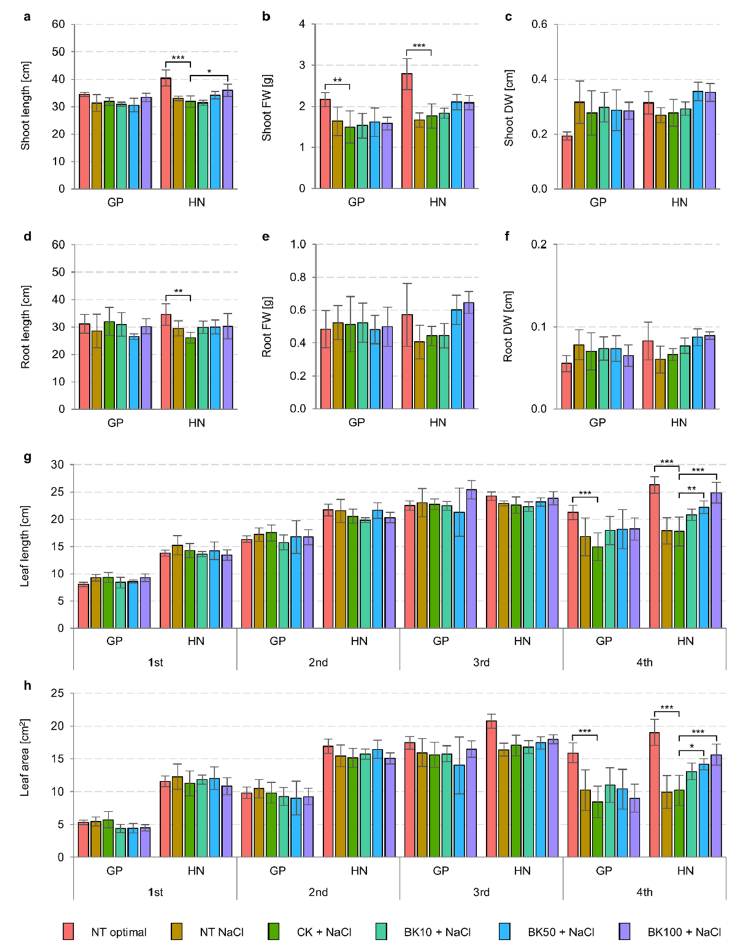
Figure 1. Treatment with bikinin resulted in phenotypic changes in barley grown under normal and salt stress conditions. Shoot length ( a ), fresh ( b ), and dry ( c ) biomass and root length ( d ), fresh ( e ), and dry ( f ) weight, and leaves’ length ( g ) and area ( h ) after bikinin treatment with 10 µM, 50 µM, and 100 µM (BK10, BK50, and BK100, respectively), compared to controls with 0.11% DMSO (CK) used as a background for solvent solutions for each bikinin concentration. Non-treated plants were used as a control for the 0.11% DMSO treatment. The values in ( a – h ) represent the mean and standard error for six biological replicates. The results of the HSD Tukey test analysis are presented in Table S1 (*, p ≤ 0.05; **, p ≤ 0.01; ***, p ≤ 0.001).